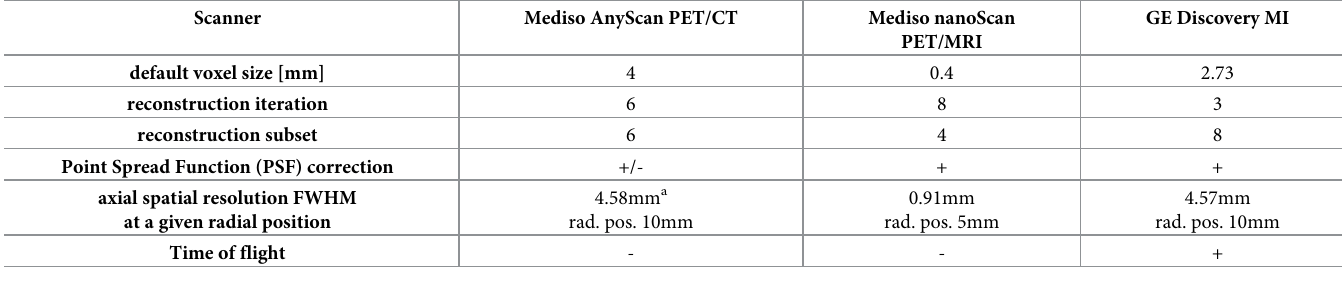
Table 1. Technical parameters and reconstruction